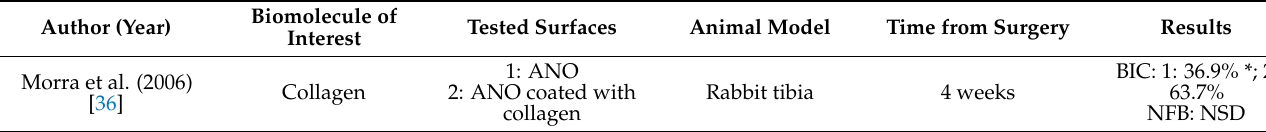
Table 5. Collagen: results from the considered